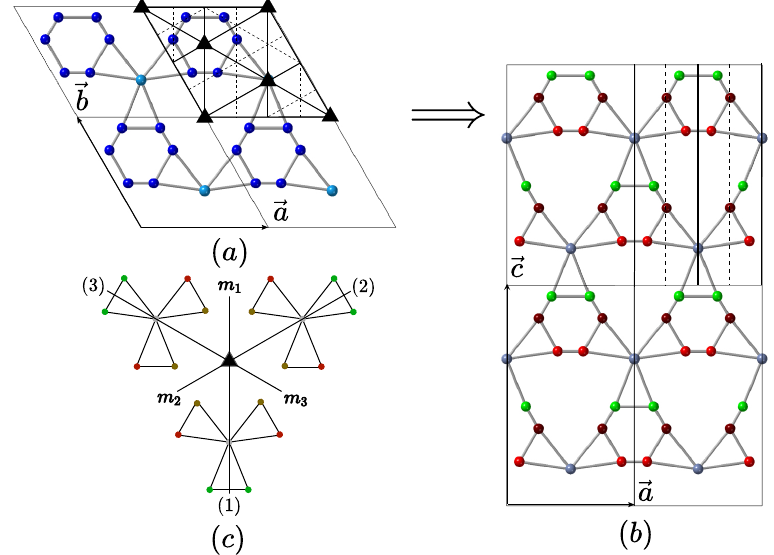
Figure 6. Group–subgroup phase transition from ( a ) p 3 m 1 ( a , b ) to ( b ) cm 1 ( a , c = a + 2 b ) generating three variants ( c ) deduced from each other by the permutation group S 3 isomorphic to 3 m